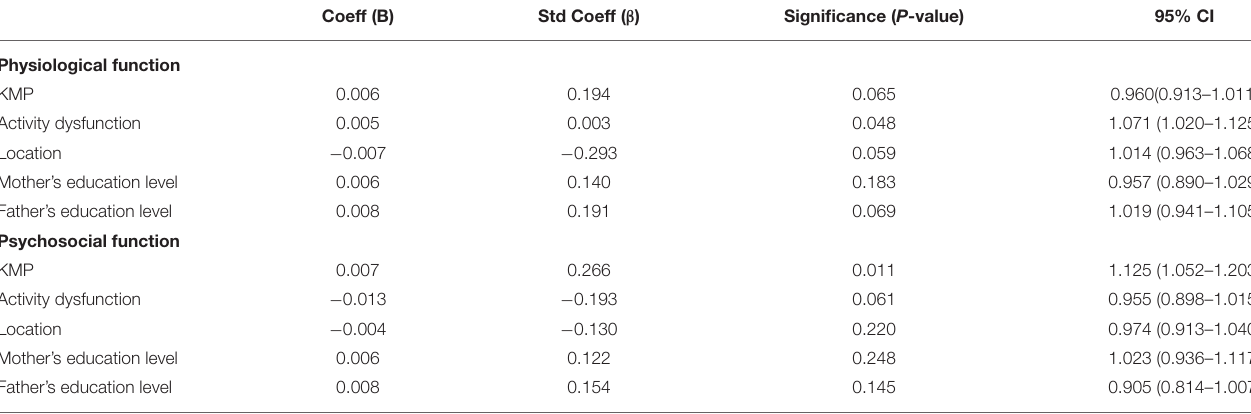
TABLE 5 | Multiple regression analysis of factors influencing quality of life score of patients with KHE. Coeff (B)